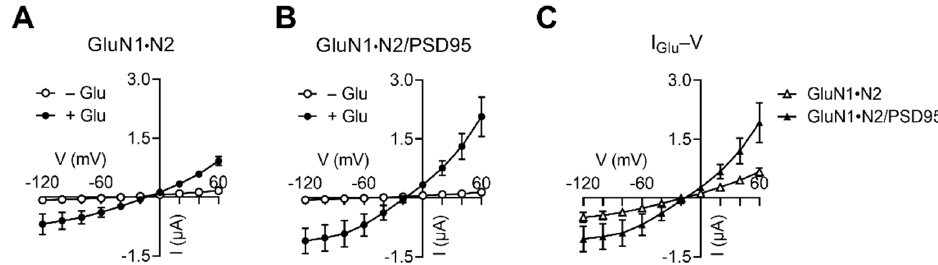
Figure 3. PSD95 increases I Glu produced by GluN1·N2. ( A ) I–V relationships of glutamate-evoked responses by GluN1·N2 ( n = 3). ( B ) I–V relationships of glutamate-evoked responses by GluN1·N2/PSD95 ( n = 5). ( C ) I Glu –V relationships. I Glu is the mean difference before and after glutamate application in ( A ) and ( B ).